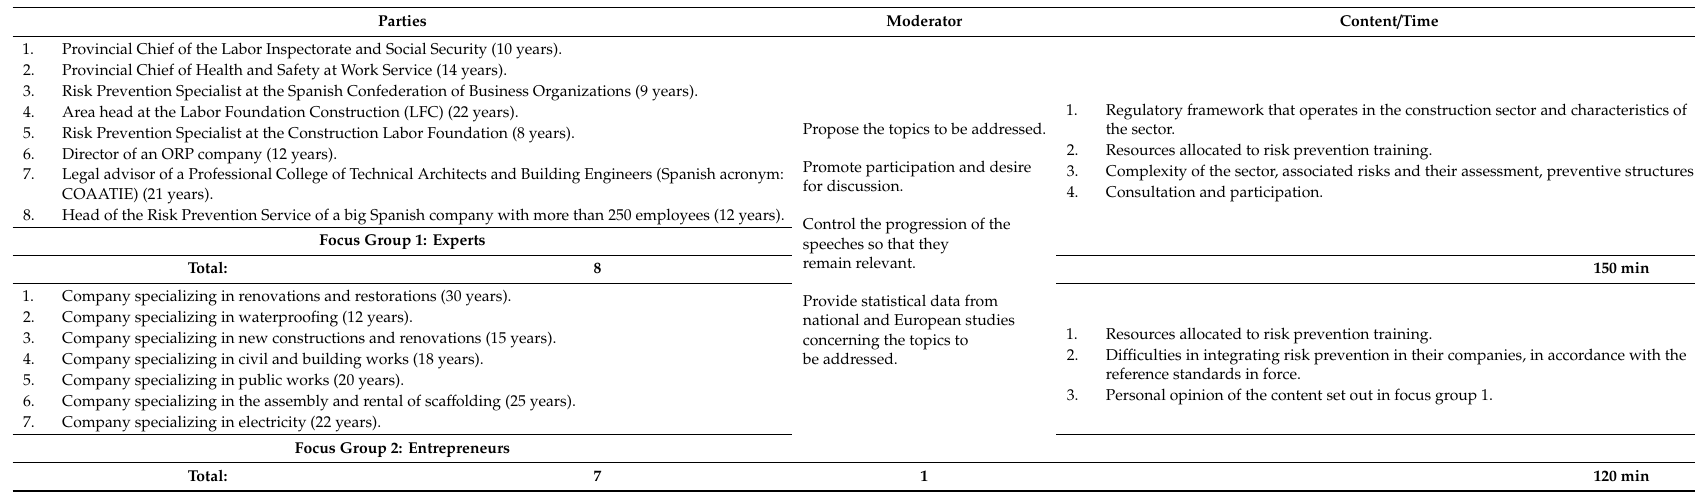
Table 3. Position of the intervening parties / experience in years, duties of the moderator, debate content and